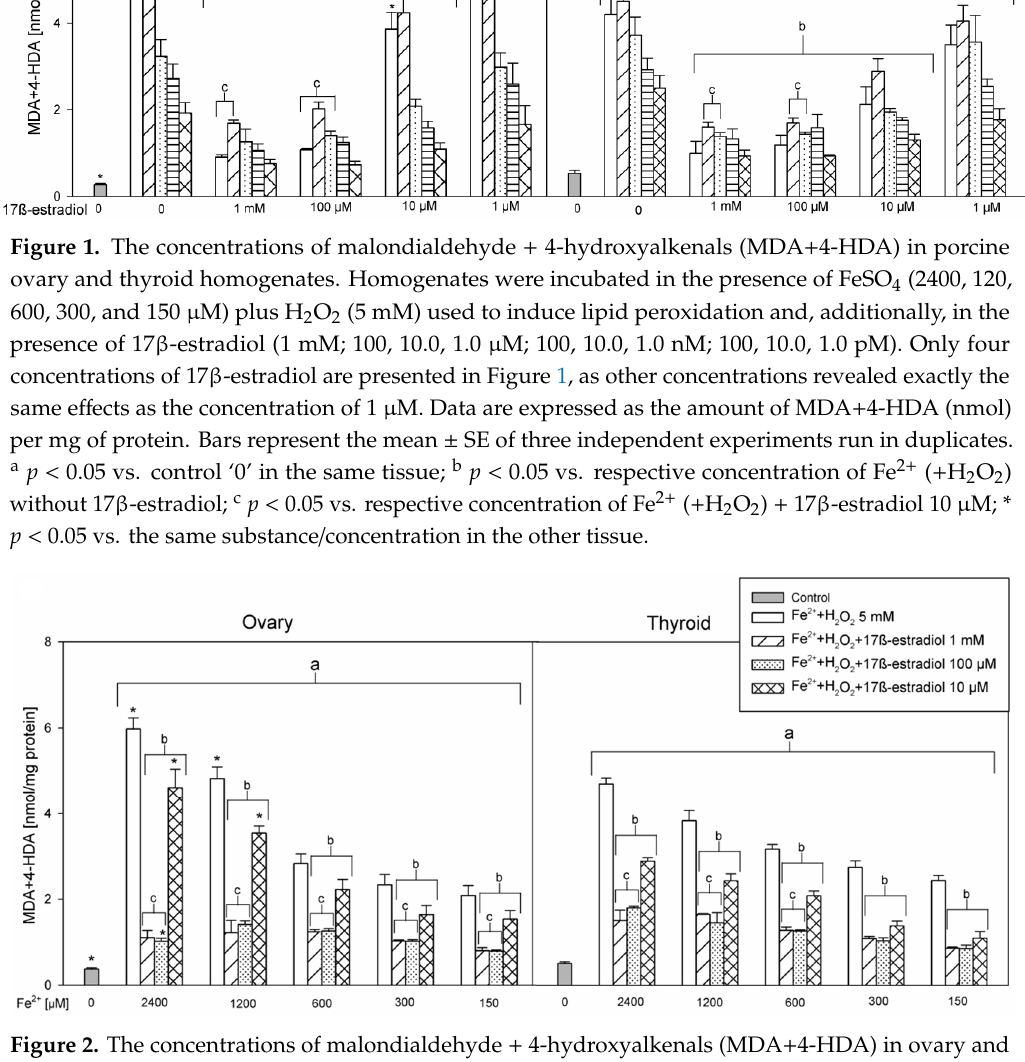
Figure 2. The concentrations of malondialdehyde + 4-hydroxyalkenals (MDA+4-HDA) in ovary and thyroid homogenates. Homogenates were incubated in the presence of FeSO 4 (2400, 1200, 600, 300, and 150 µM) plus H 2 O 2 (5 mM) with or without 17β-estradiol (1 mM, 100 µM and 10 µM). Data are expressed as the amount of MDA+4-HDA (nmol) per mg of protein. Bars represent the mean ± SE of three independent experiments run in duplicates. a p < 0.05 vs. control ‘0’ in the same tissue; b p < 0.05 vs. respective concentration of Fe 2+ (+H 2 O 2 ) without 17β-estradiol; c p < 0.05 vs. respective concentration of Fe 2+ (+H 2 O 2 ) + 17β-estradiol 10 µM; * p < 0.05 vs. the same substance/concentration in the other tissue.